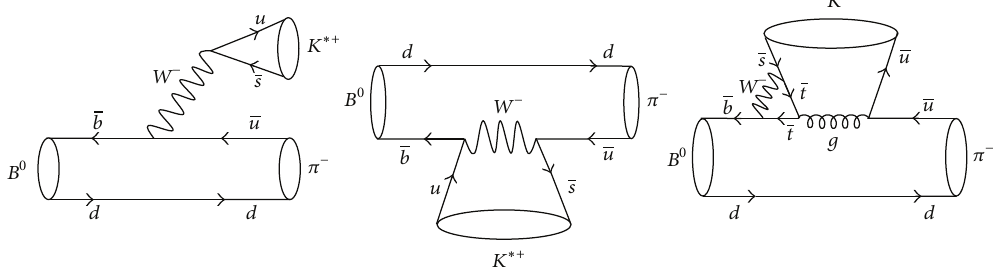
Figure 2: Quark diagrams illustration of the process of the 𝐵 0 → 𝐾 ∗+ 𝜋 −